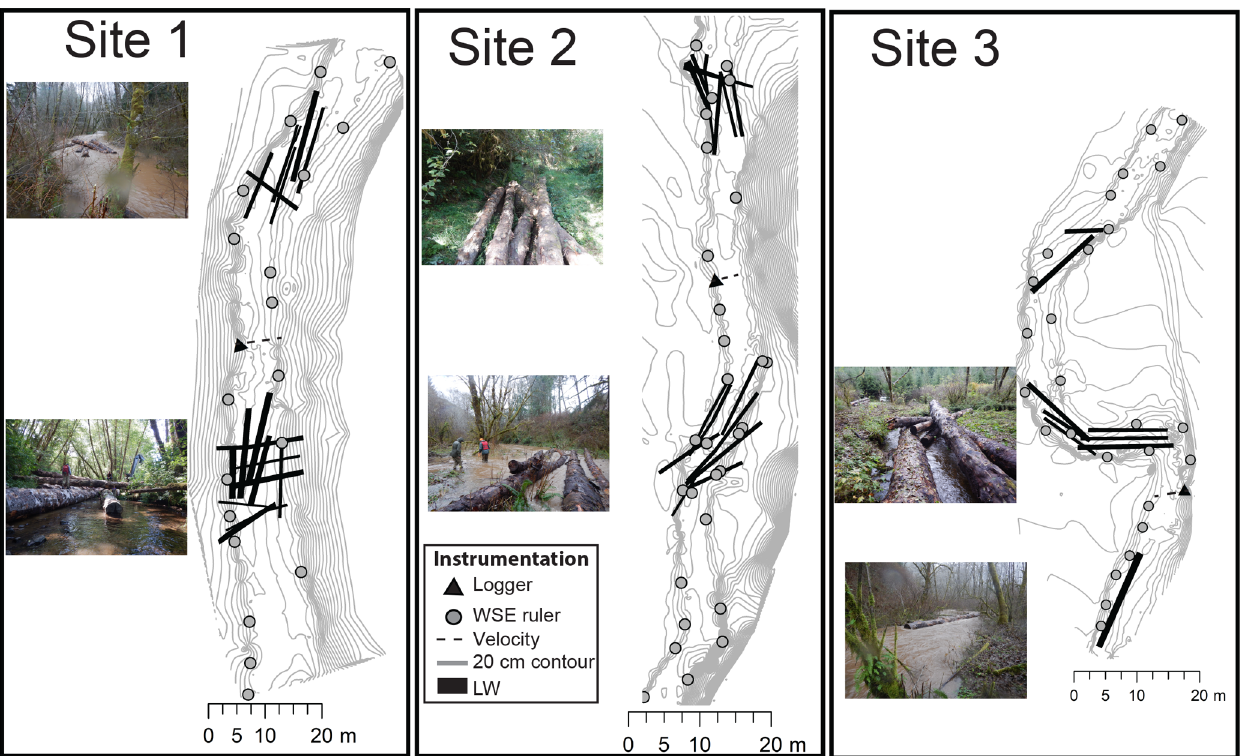
Figure 2. Topography (derived 0.2m contours) and location of introduced large wood (LW), water surface elevation (WSE) monitoring rulers (circles), water level loggers (triangle), and location of velocity measurements (dash line). Flow direction is from top to bottom in all three